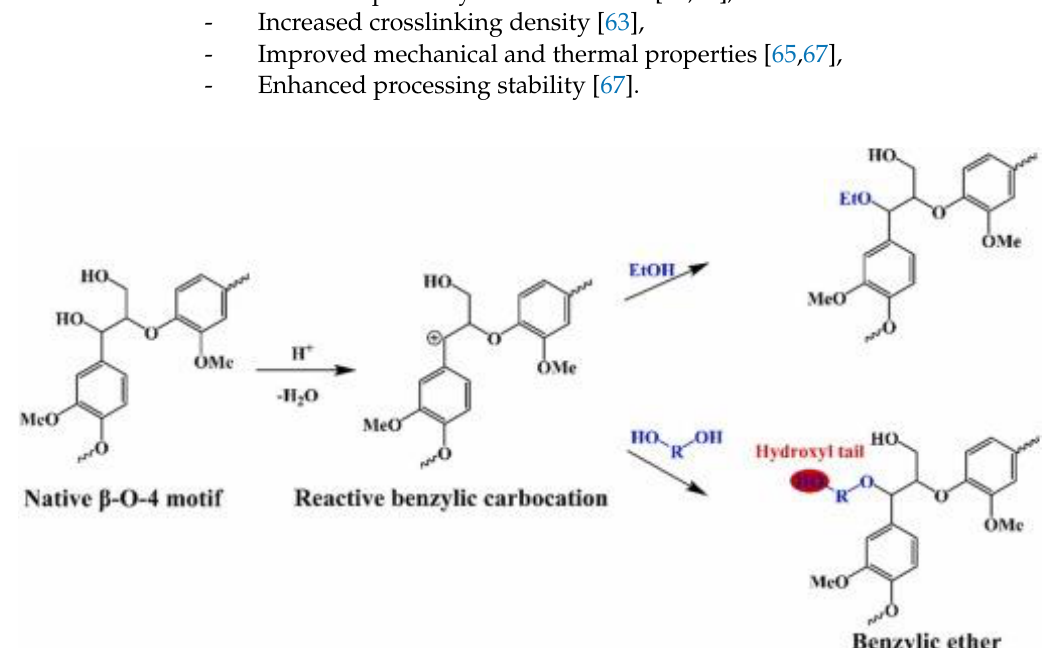
Figure 7. Enhancing α -etherification of lignin by diol pretreatment at a mild temperature (120 °C) to isolate lignin for producing 5 times the monomer yield of that from technical ethanol pretreatment (170 °C) by hydrogenolysis. Reproduced from [98], with the permission of Elsevier.